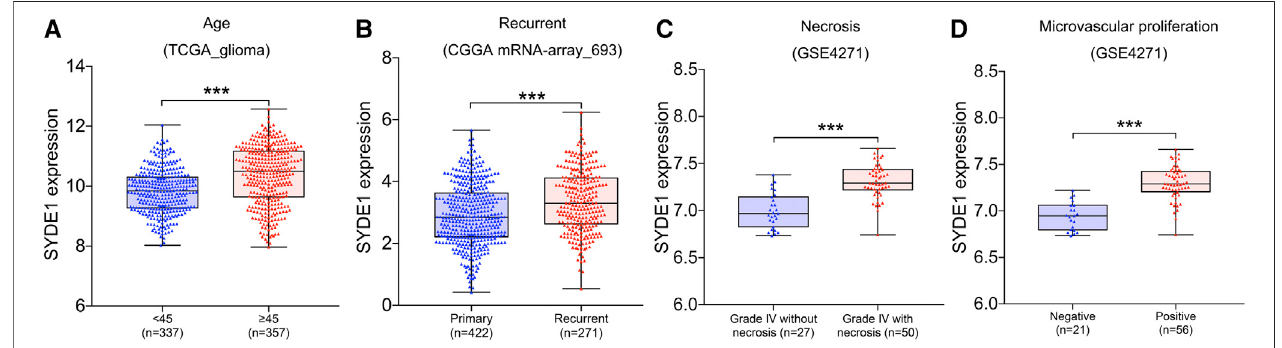
FIGURE 2 | The association between SYDE1 expression and patient age, tumor recurrence, tumor necrosis or tumor microvascular proliferation. (A) The association between SYDE1 expression and patient age. (B) The association between SYDE1 expression and glioma recurrence. (C) The association between SYDE1 expression and glioma necrosis. (D) The association between SYDE1 expression and glioma microvascular proliferation. *, p.value < 0.05; ***, p.value < 0.001.